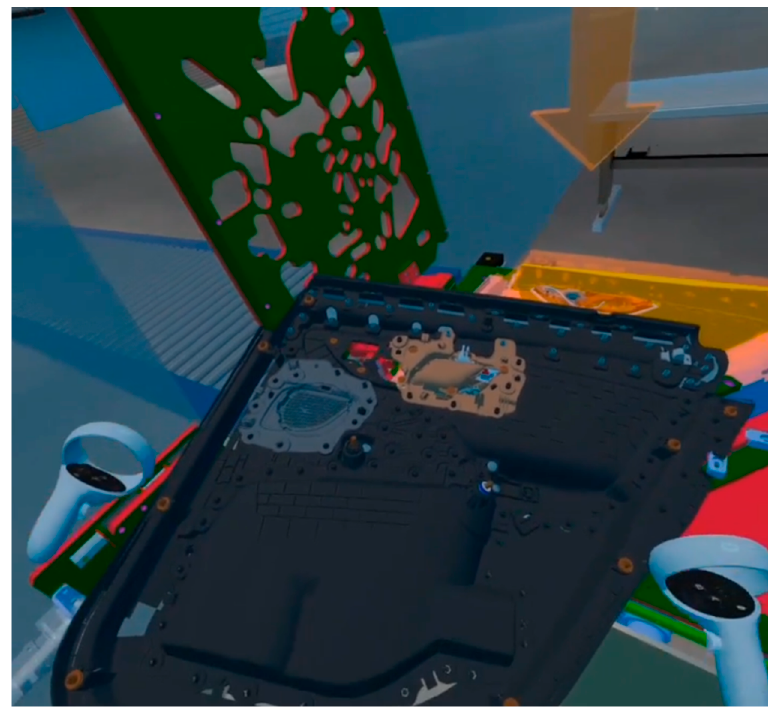
Figure 3. Sample of the production line